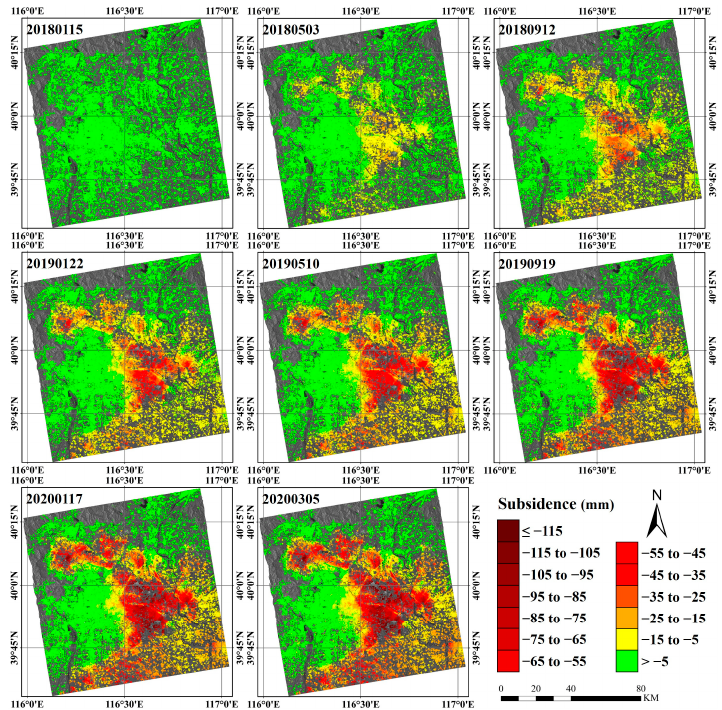
Figure 6. Time series of cumulative subsidence before the COVID-19 outbreak.